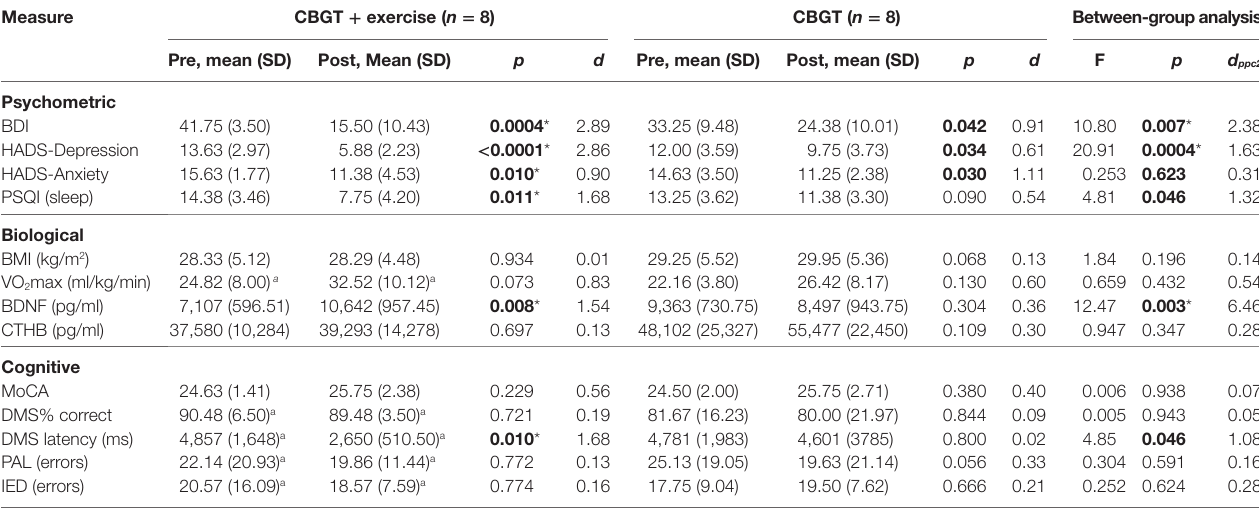
TaBle 3 | Pre–post changes for depressed